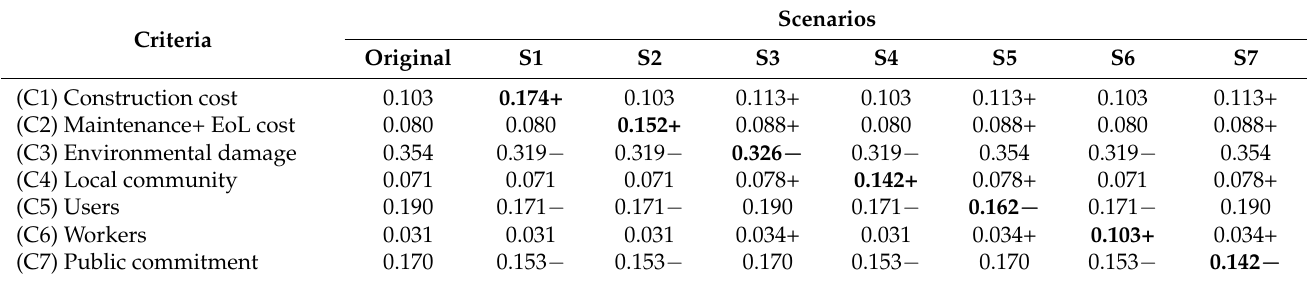
Table 14. Different weighting scenarios for aggregation in the hybrid ANP-ELECTRE IS model.